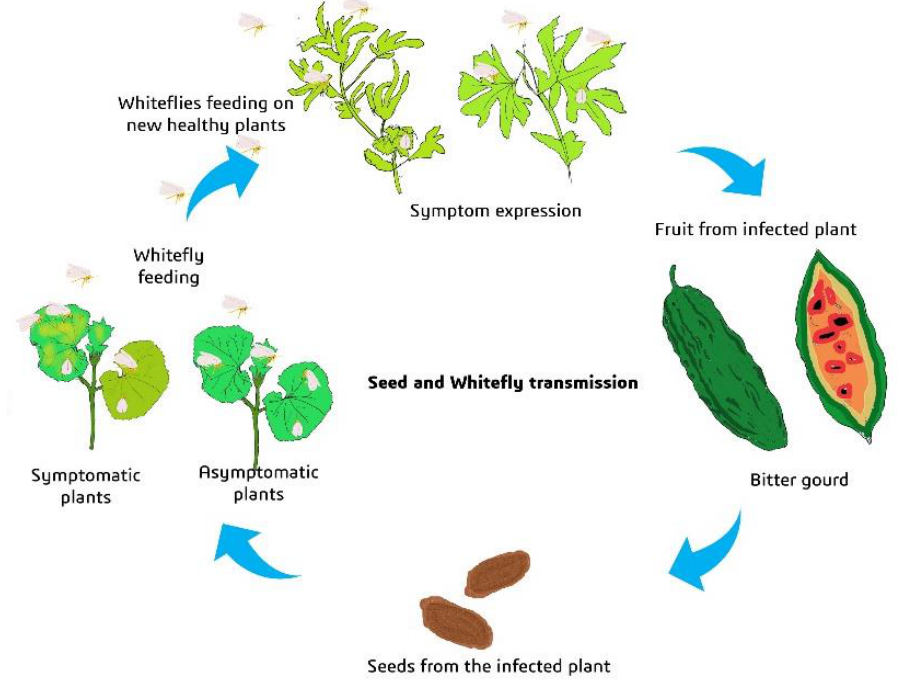
Figure 7. Seed as a potential source of inoculum for the begomoviruses.